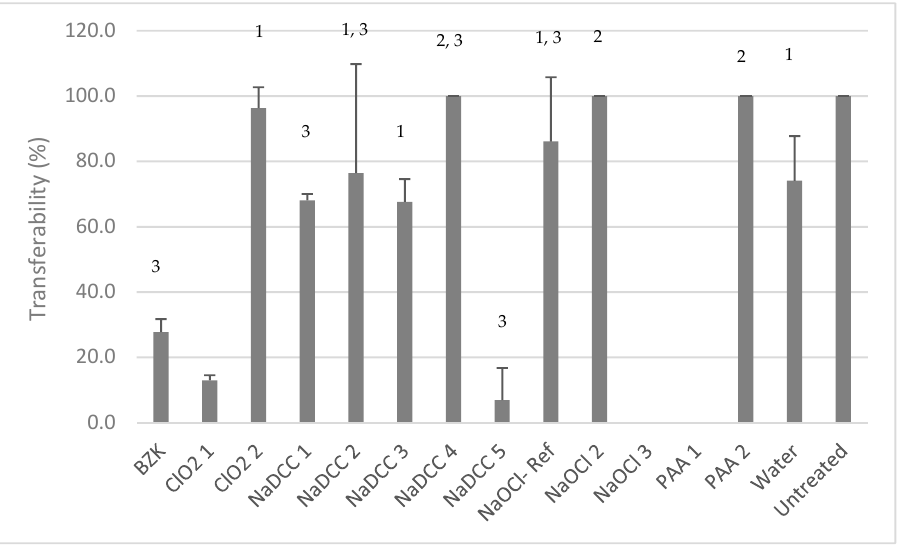
Figure 3. Product efficacy in preventing C. auris transferability post-wiping. 1: indicates no statistical difference (one-way ANOVA, for each pair p > 0.05) in transferability; 2: higher transferability (one-way ANOVA, for each pair p < 0.05) than with water control; and 3: indicates that only two biological replicates were performed.